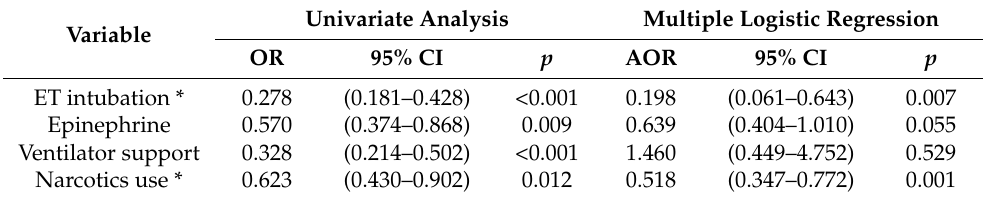
Table 5. Multiple logistic regression analyses of hospital care between early DNR and late DNR